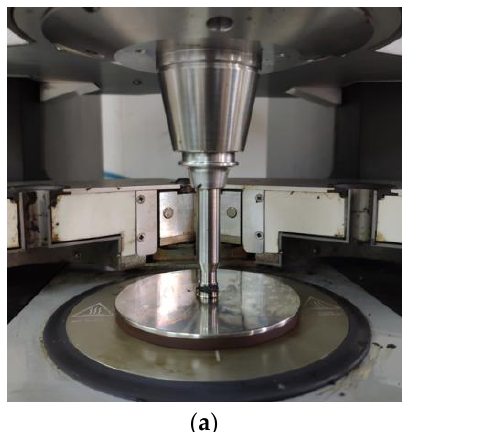
( b ) Figure 2. Fatigue characterizing tests: ( a ) indirect tensile fatigue test (ITFT) test for mixtures; ( b ) 4PB test for mixtures.